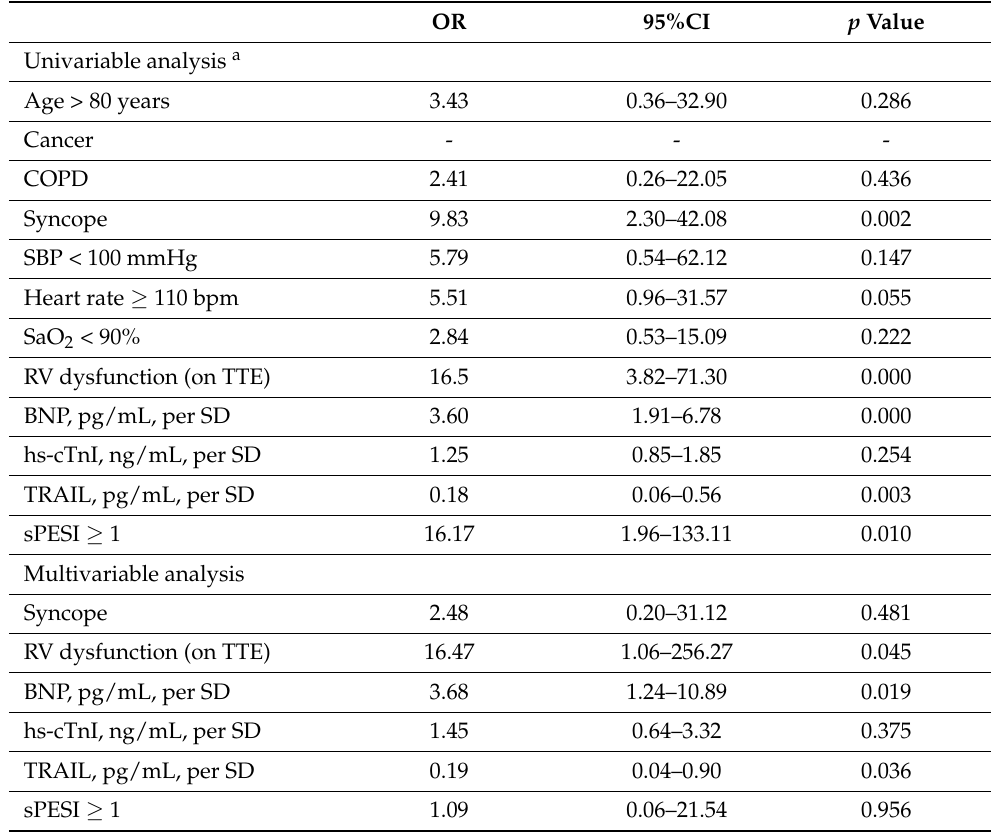
Table 2. Predictors of an adverse 30-day